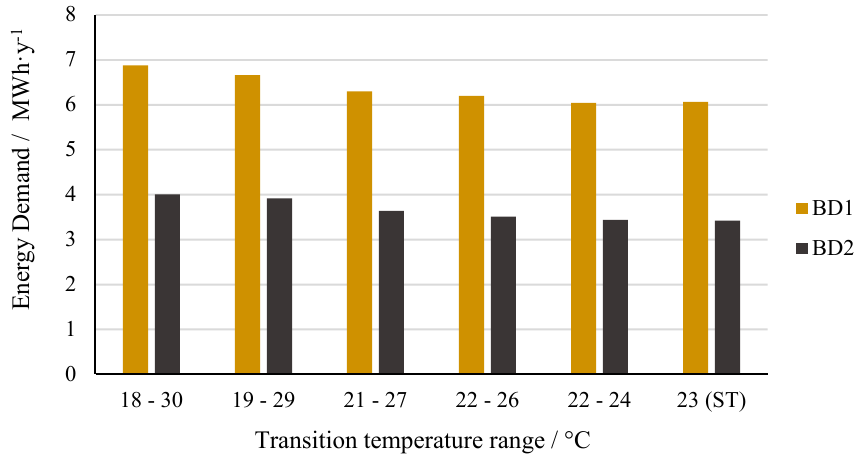
Figure 8. Annual final energy demand for building configurations BD1 and BD2, located in Abu Dhabi, the United Arab Emirates, considering different transition temperature ranges.